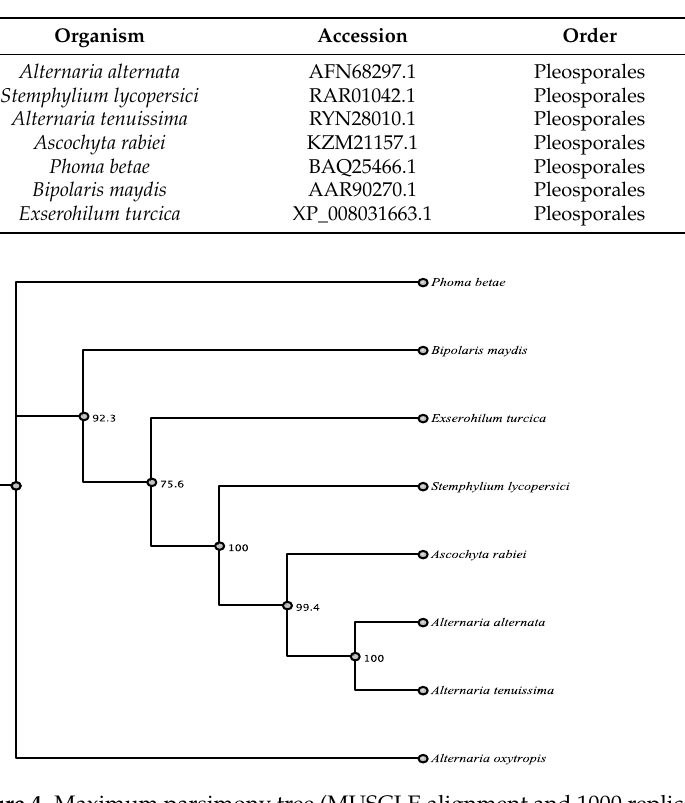
Figure 3. Maximum parsimony tree (MUSCLE alignment and 1000 replicates). Alternaria arborescens was used as the outgroup. Fungi in tree are pblast results of 2122 sequence. Table 5. Percent amino acid (aa) identity of pblast results of PKS 96133 sequence. Fungal order within the class Dothideomycetes.